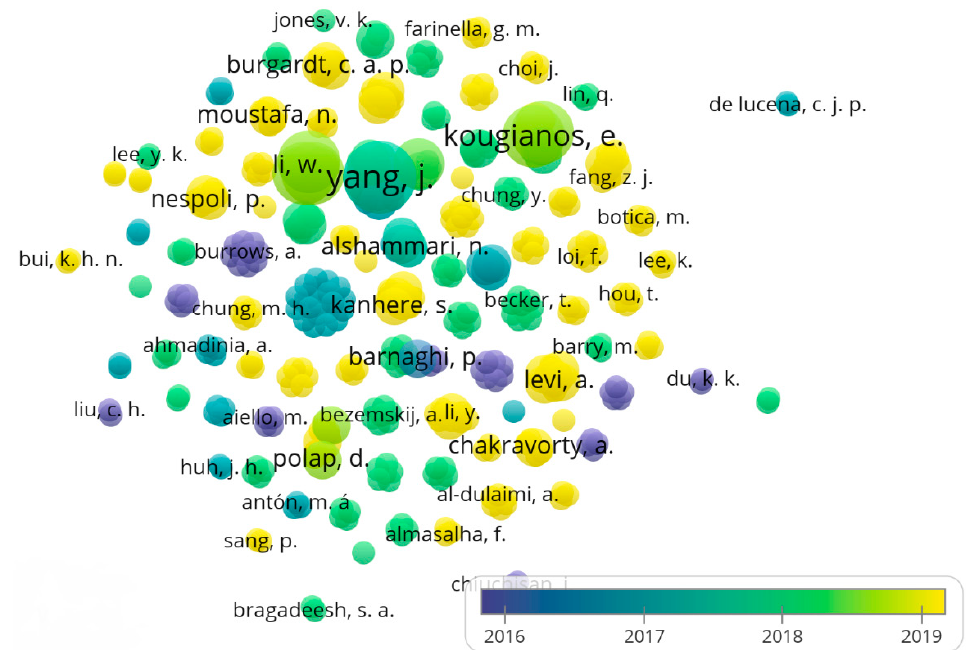
Figure 2. A network of all 430 co-authors of the AISH bibliographic dataset co-authorship network using full counting. AISH, applications of AI and the IoT in smart homes.